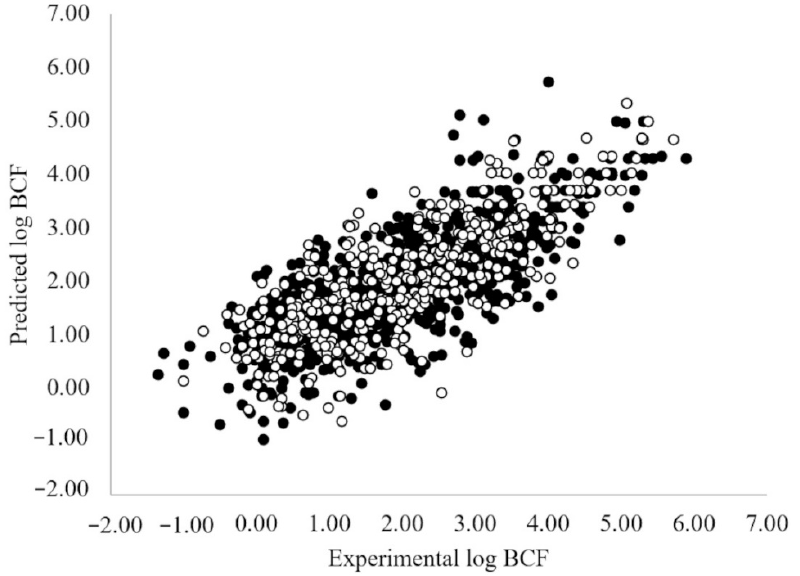
Figure 1. Experimental vs. predicted log BCF values of the best MLR OLS model selected from the step-up population (Equation (1)). Black Dots = training set. White dots = prediction set.